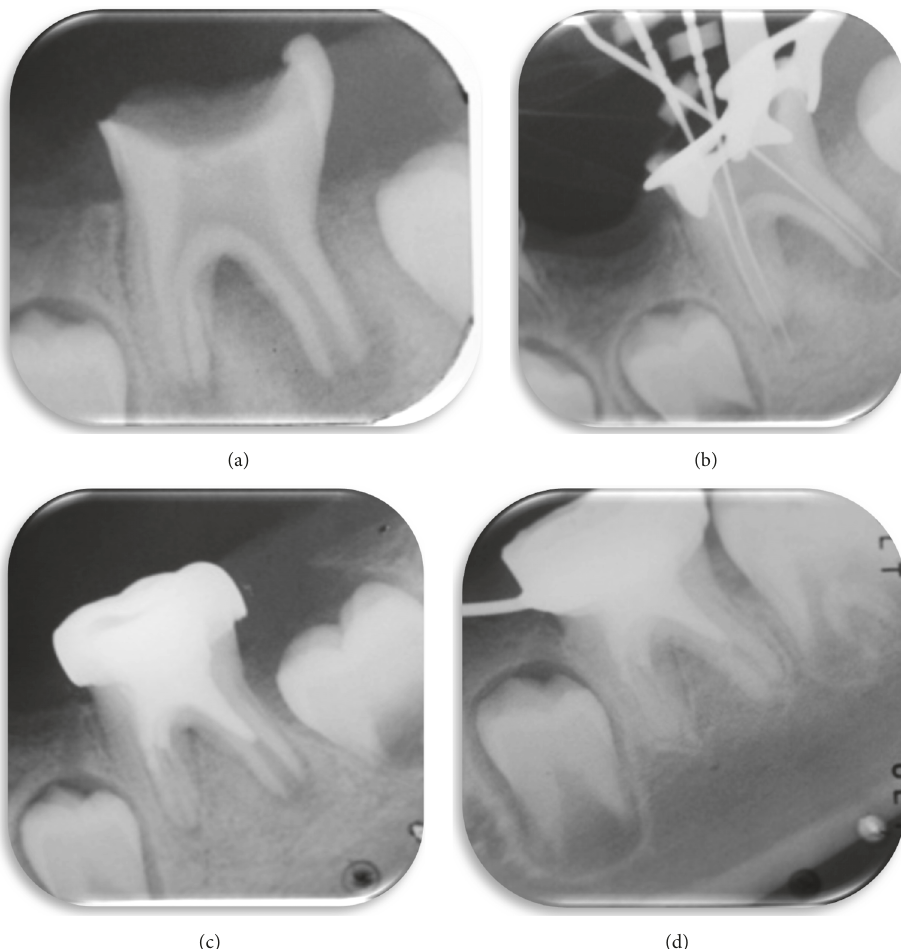
Figure 4: (a) Periapical radiograph taken at the first visit, showing large occlusal caries on tooth 36 with pulp exposure, open apices, and a radiotranslucency encompassing the furcation and the distal root of the molar. (b) Size 15K-files are used for apical irritation to induce bleeding. (c) Completion of revascularization treatment after placing the MTA and metal crown. (d) Check-up at 9 months. The radiotranslucency has completely disappeared. Obliteration of the two mesial canals can be